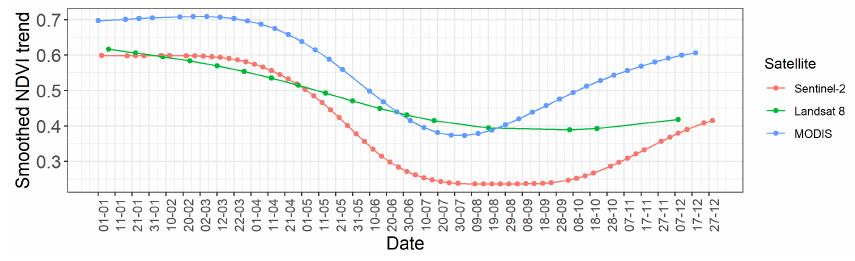
Figure 8. Comparison of the NDVI trends derive from Sentinel-2, Landsat-8, and MOD09Q1 (MODIS) data.